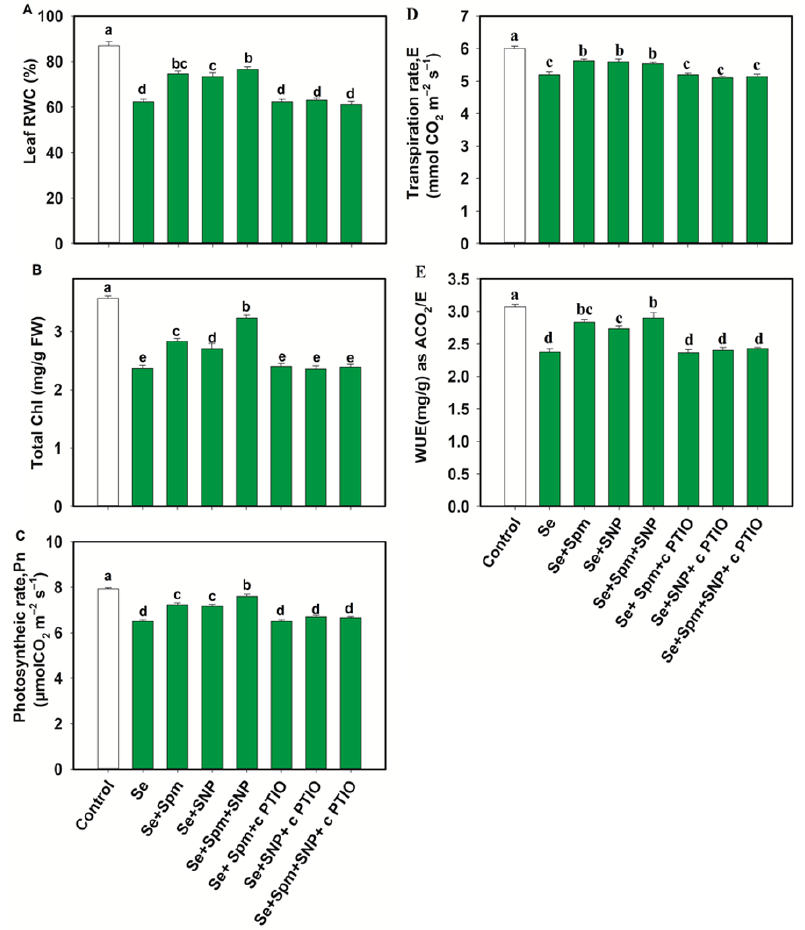
Figure 4. Leaf relative water content (RWC) ( A ), total chlorophyll (Chl) ( B ), photosynthetic rate (Pn) ( C ), transpiration ( D , E ) and water use efficiency (WUE) ( E ) in leaves of 49-day-old wheat plants grown under control and Se stress (1 mM) sprayed with 1.0 mM Spm or 0.1 mM SNP alone or together, combined with 0.1 mM cPTIO, a NO scavenger. Data presented are the mean (± SE) of three replicates, and bars with dissimilar letters (a–d) represent significantly different results at the p ≤ 0.05 level based on Fisher’s LSD test.